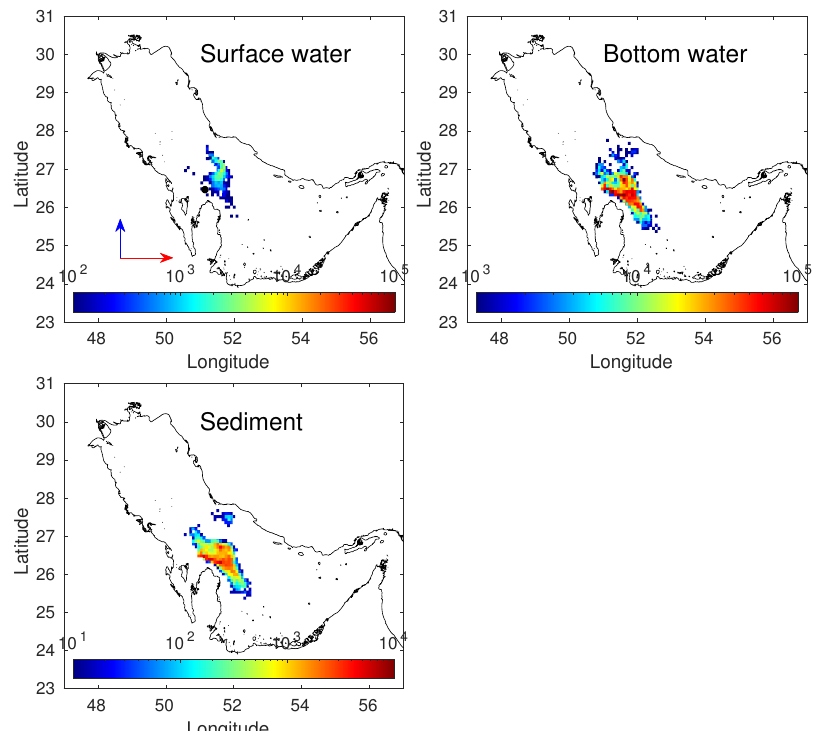
Figure 6. The same as Figure 5 but adding winds due to a local storm. See the main text for details. Arrows in the surface water map indicate the wind direction: west (red) and south (blue)